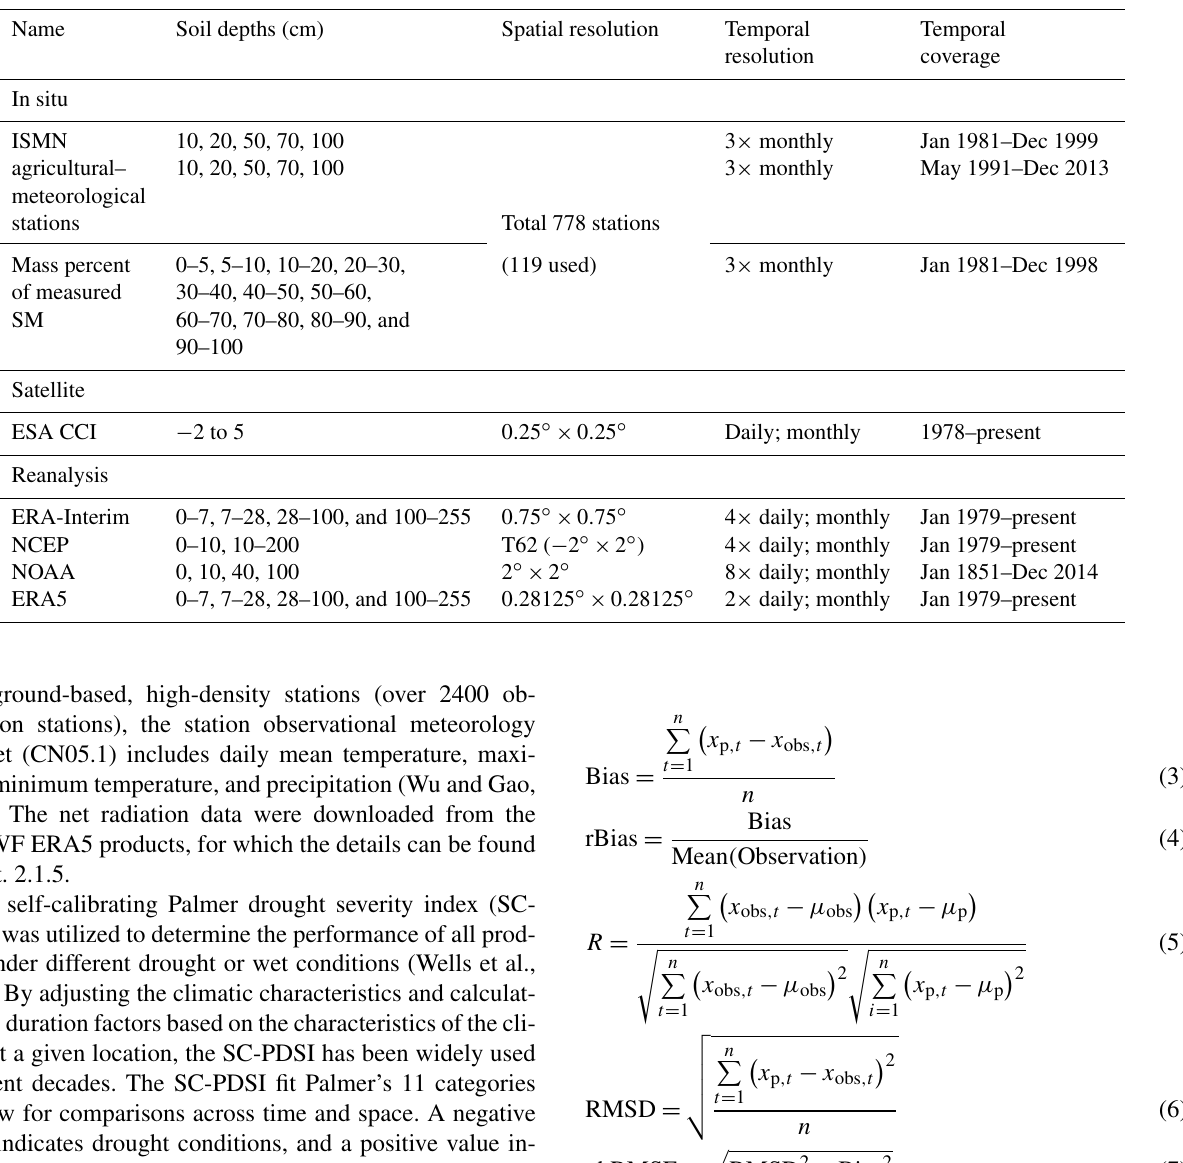
Table 1. Details of the SM products used in the